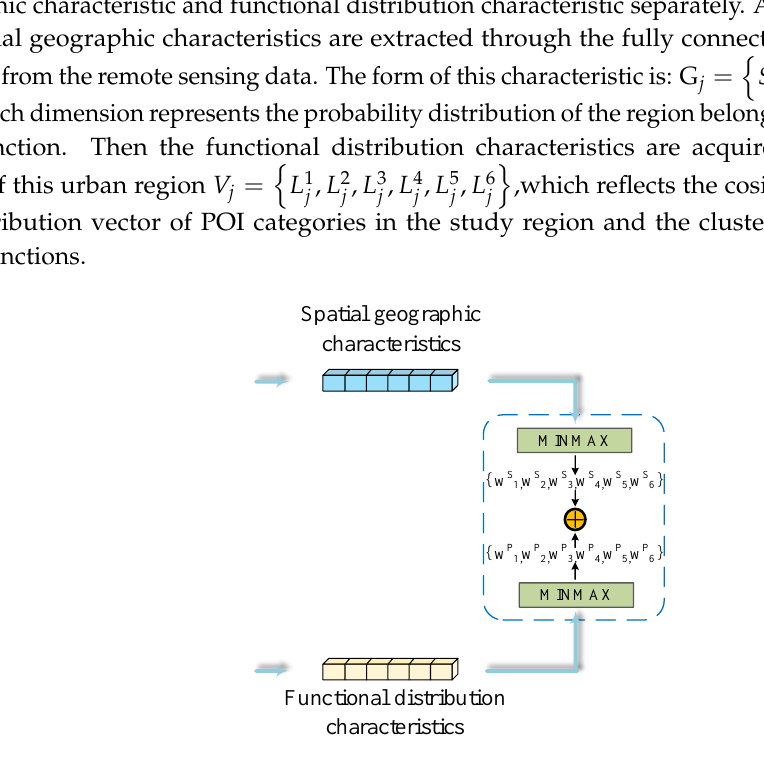
Figure 8. The architecture of the RPF